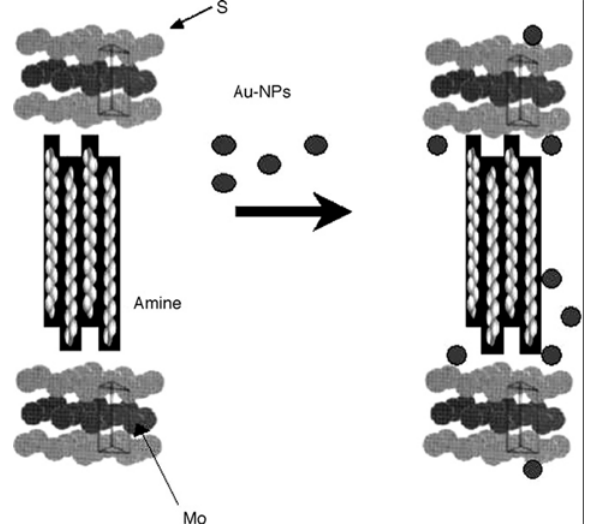
Figure 11. Schematic representation of the functionalization of the Li compound with gold nanoparticles and their position in the lamellar system. The MoS represented in the 1T conformation. Reproduced from reference [122] with permission from